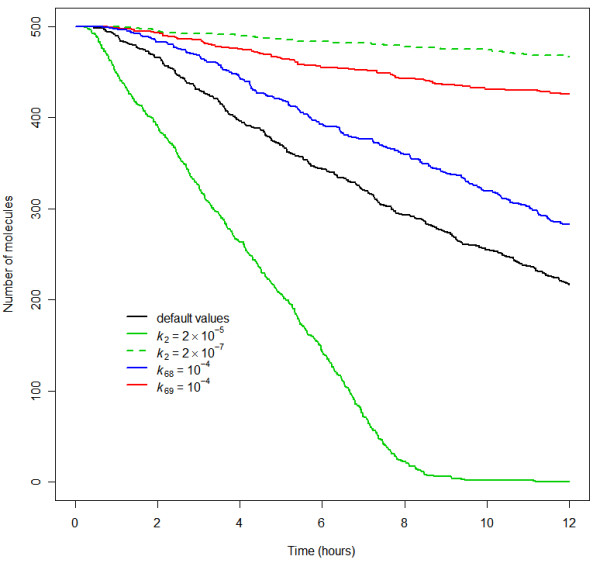
Model parameters that affect protein half-life. Results are shown for a typical simulation, for a 12 hour period. Protein synthesis was blocked by setting k1 = 0 with all other parameters as in Tables 2 and 3 except where indicated. The curves show the decline in total protein with time. The half-life is the time when the total protein level is equal to 250.